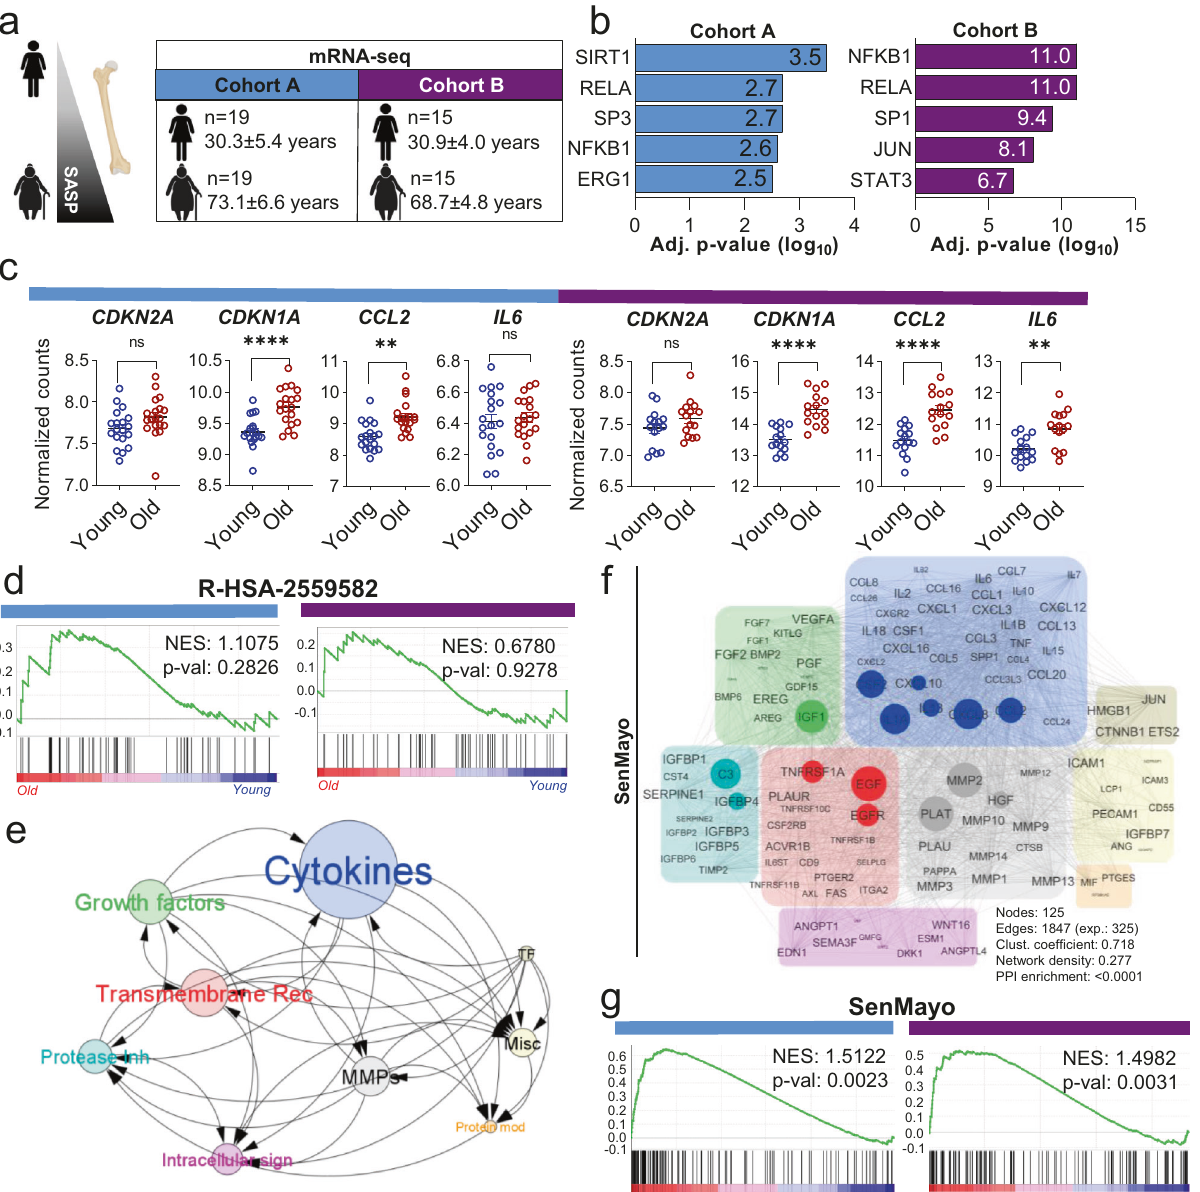
Fig. 1 | Development and validation ofthe SenMayo gene set.a Humansamples from Cohort A (bone and bone marrow biopsies) and cohort B (highly enriched osteocytefractions)wereusedfortranscriptome-wideRNA-seqanalyses; b Making use of TRRUST analyses 30 , we found several in fl ammation- and stress-associated genes,including SIRT1 and NFKB1 ,tobeupregulatedintheelderlywomen; p values were adjusted according to Benjamini – Hochberg. c In both gene sets, CDKN1A/ P21 Cip1 and several SASP markers such as CCL2 and IL6 showed consistent upregu- lation with aging,while CDKN2A / p16 Ink4a (due to comparatively low expression) did not change signi fi cantly. Two-sided unpaired t-tests except for CCL2, where a Kolmogorov – Smirnov test was used (cohort A: CDKN2A : p =0.0834; CDKN1A : p <0.0001; CCL2: p=0.0034; IL6: p =0.6391; cohort B: CDKN2A : p =0.1658, CDKN1A : p <0.0001; CCL2: p<0.0001, IL6 : p =0.0017). d The commonly used senescence/SASP gene set (R-HSA-2559582) failed to predict the aging process